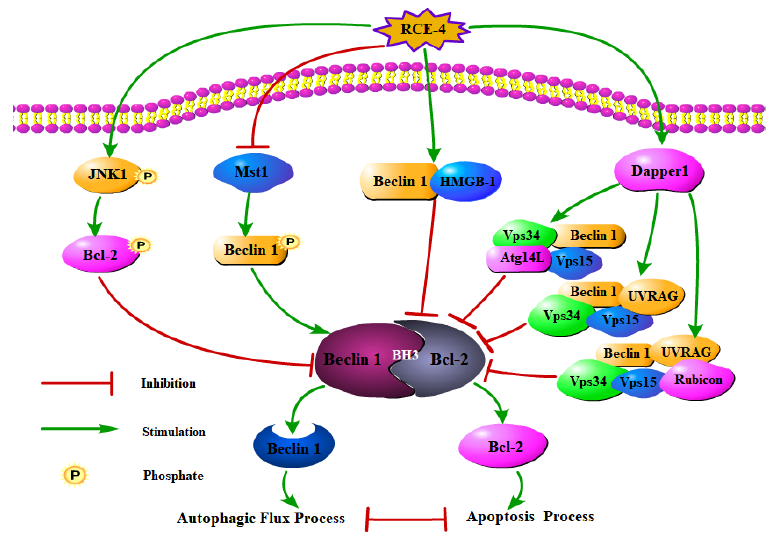
Figure 4. various signal pathways co-regulated the formation of intracellular Bcl-2–Beclin 1 complex. The results of western blot (Figure 5a,b) showed that the expression of Dapper1, p- Beclin 1, p-Bcl-2 and p-JNK1 significantly increased and Mst 1 obviously decreased after Ca Ski cells treated with RCE-4 of 8 μmol/L for 6, 12 and 24 h, this inhibited the formation of the Bcl-2–Beclin 1 complex ( p < 0.001). Additionally, the relative contents of Beclin 1–